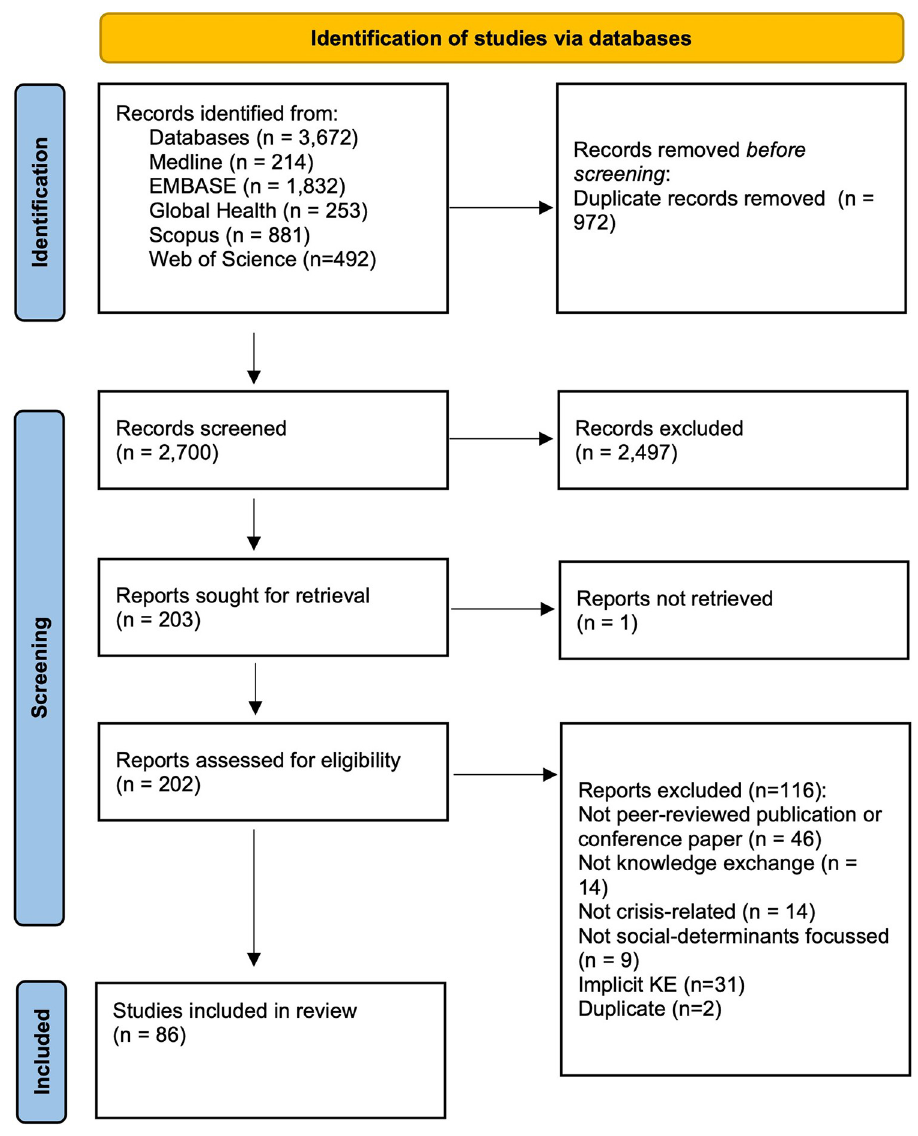
Fig 1. PRISMA 2020 flow